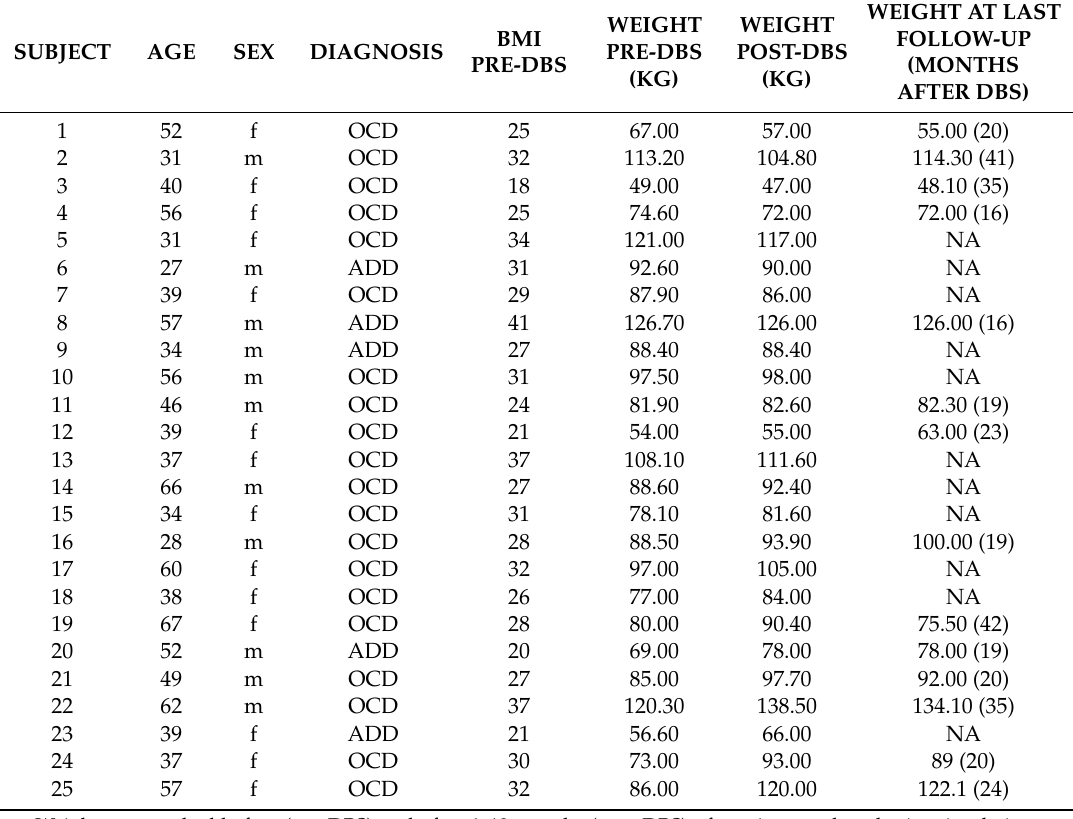
Table 1. Demographic data and weight changes.